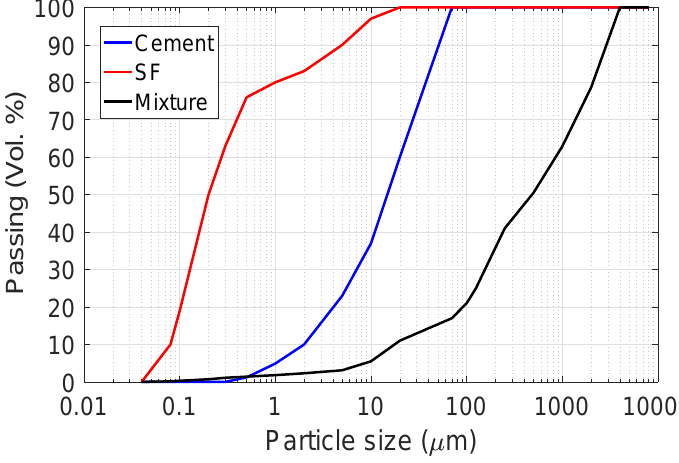
Figure 1. Particle size distributions of cement, silica fume (SF), and the concrete mixture. Table 2. Physical properties of aggregates